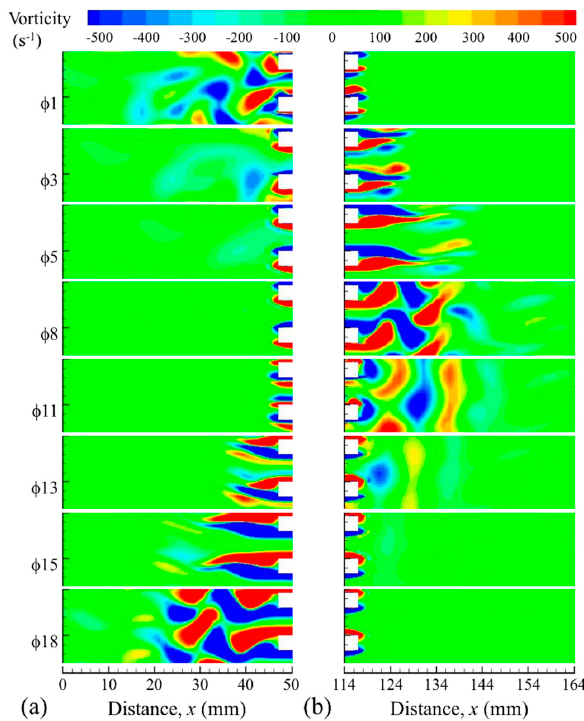
Figure 13. Vorticity contours at the left ( a ) and right ( b ) ends of heat exchanger assembly calculated from the SST k- ω model. The drive ratio is 0.83%. Arbitrary distance x is measured along the “viewing area”; vertical axis, y , is omitted for simplicity; the ratio of x : y is 1:1. Appl. Sci. 2017 , 7 , 673